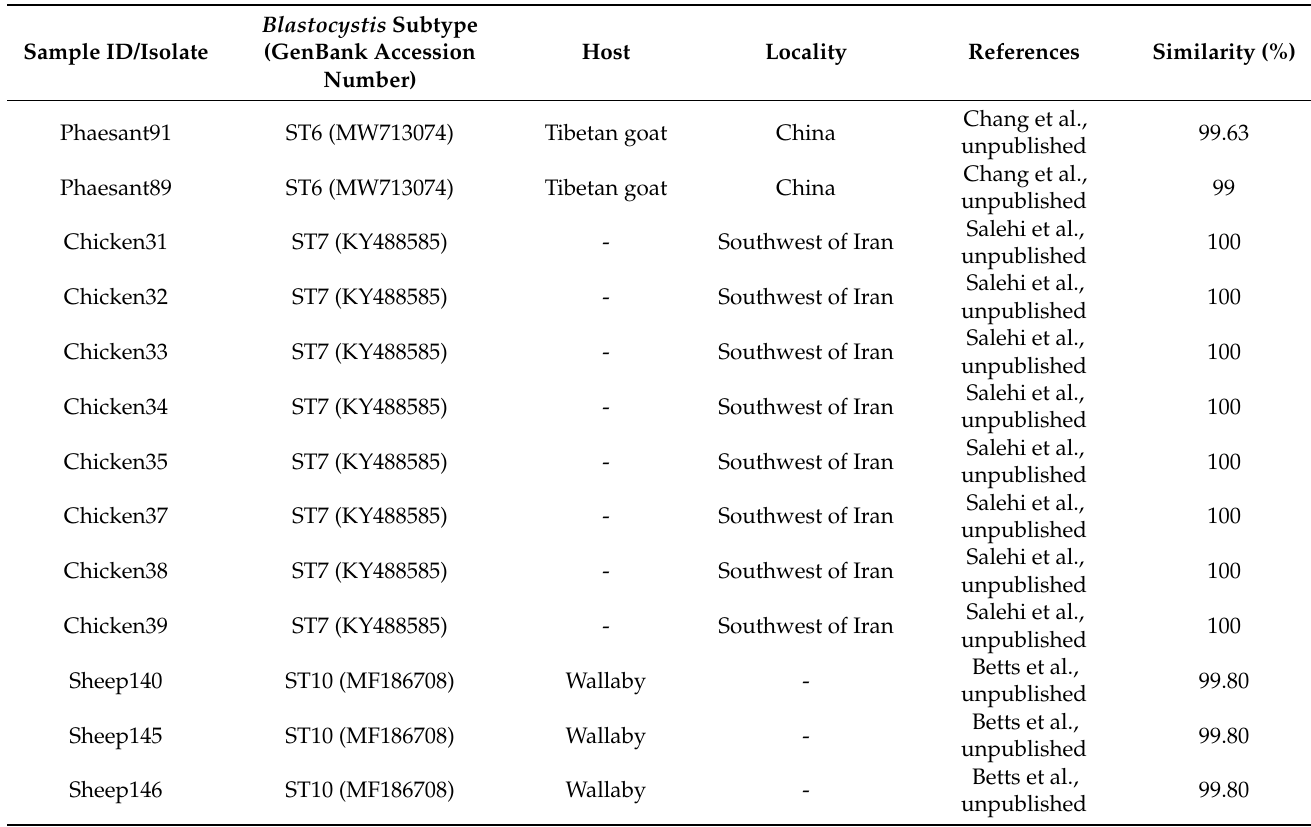
Table 2. BLAST correspondence of Blastocystis sequences obtained in the present study with those Blastocystis subtypes (STs) available in the GenBank™ database reported with their host, geographic origin, and accession number.